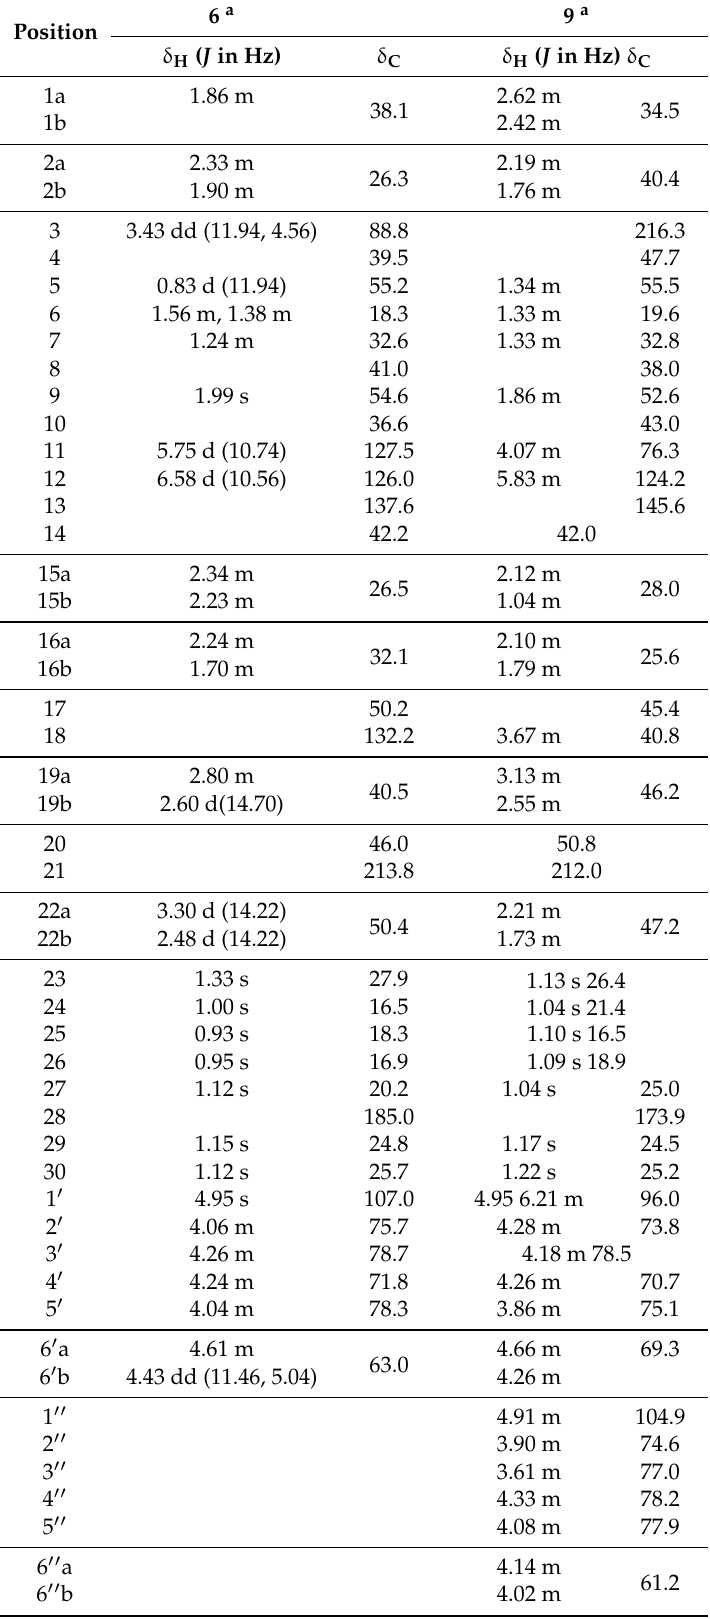
Table 1. 1 H-NMR spectral data of compounds 6 and 9